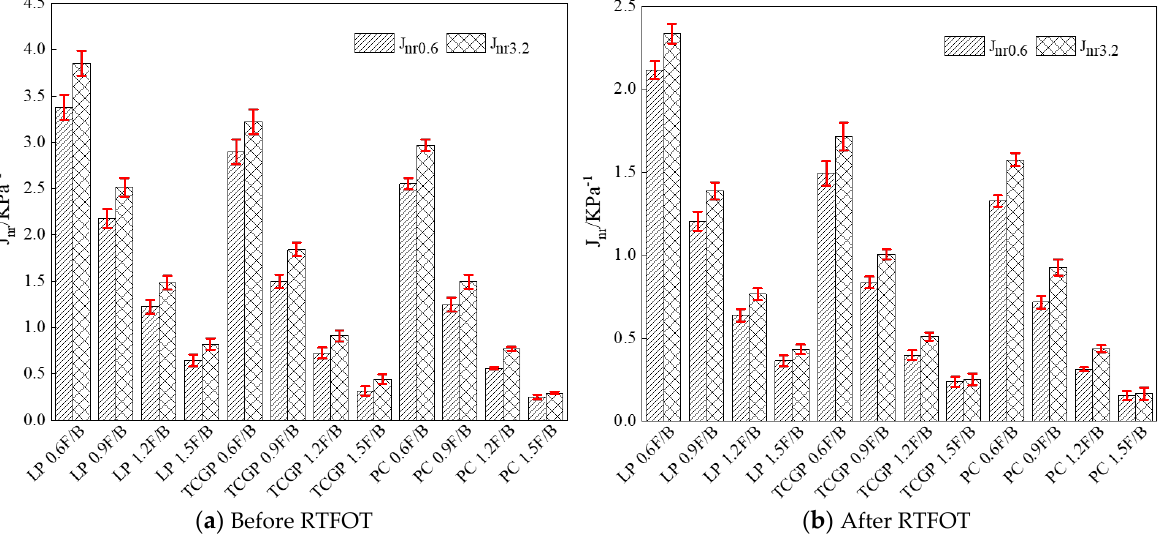
Figure 12. Test results of J nr of different emulsified asphalt mastics (70 ℃ ).